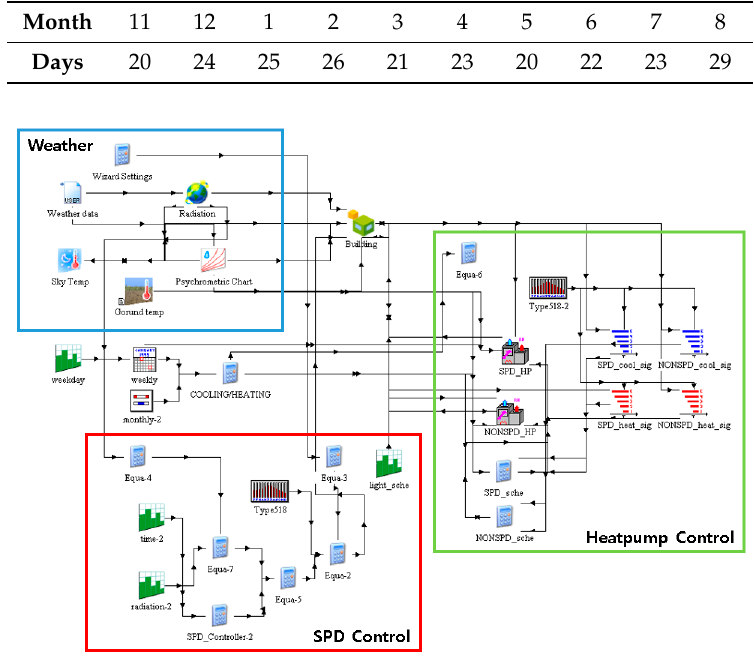
Table 6. The number of days the simulation was conducted per month.